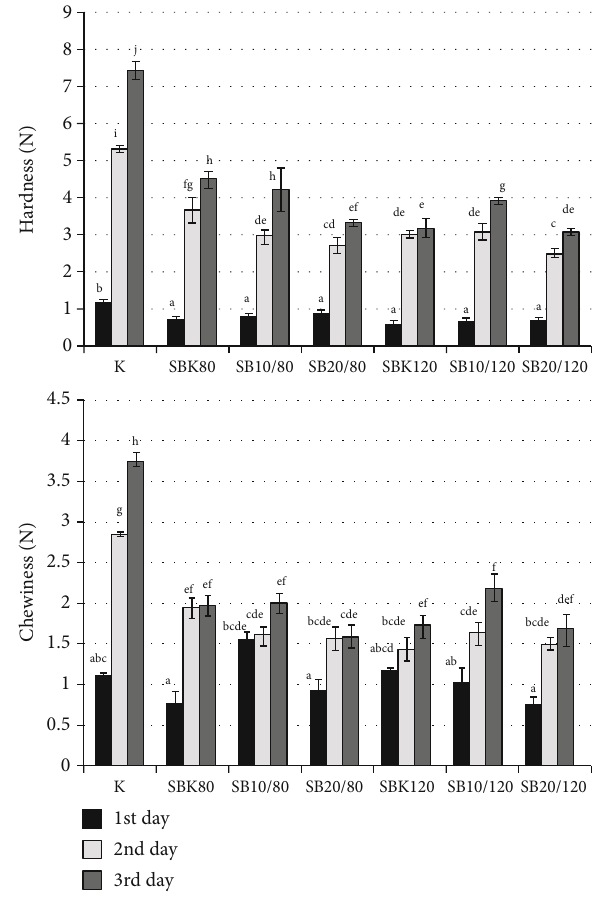
Figure 2: Changes in selected texture parameters of gluten-free bread within 3 days of storage: K control bread, SBK 0/80, and SBK 0/120, starch bread with 10% rice extrudate processed at 80 and 120 ° C, respectively; SB10/80, SB10/120, starch bread with 10% rice extrudate containing 10% fruit pomace, processed at 80 and 120 ° C, respectively; SB20/80, SB20/120, starch bread with 10% rice extrudate containing 20% fruit pomace, processed at 80 and 120 ° C, respectively (values signed with the same letters do not di ff er signi fi cantly at 0.05 level of con fi dence). Presented data are mean value of 4